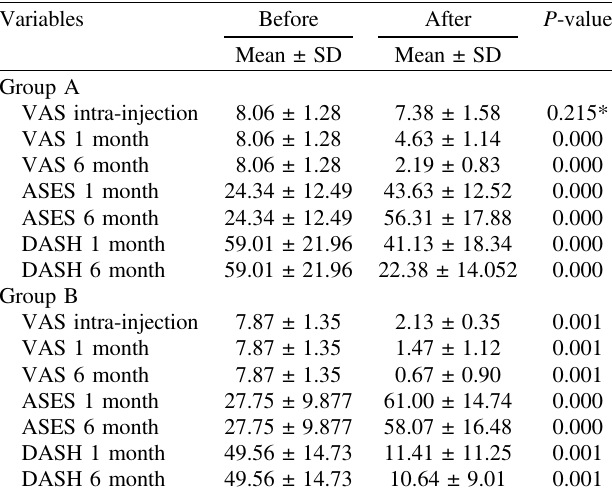
Table 2. Functional assessment for groups A and B before and after intervention.